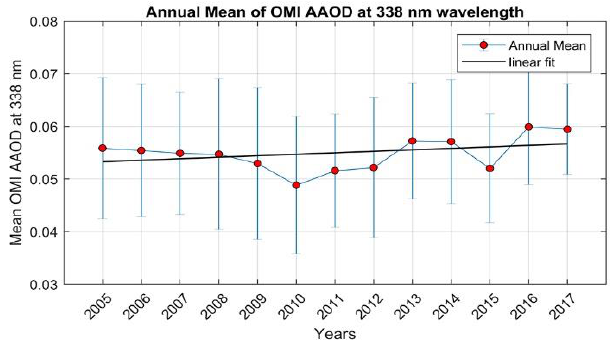
Figure 5. Annual mean of AAOD for the period of 2005 – 2017 along with standard deviation. Linear trend has also been displayed to observe the statistical variability of absorbing aerosol over the Himalayan region.